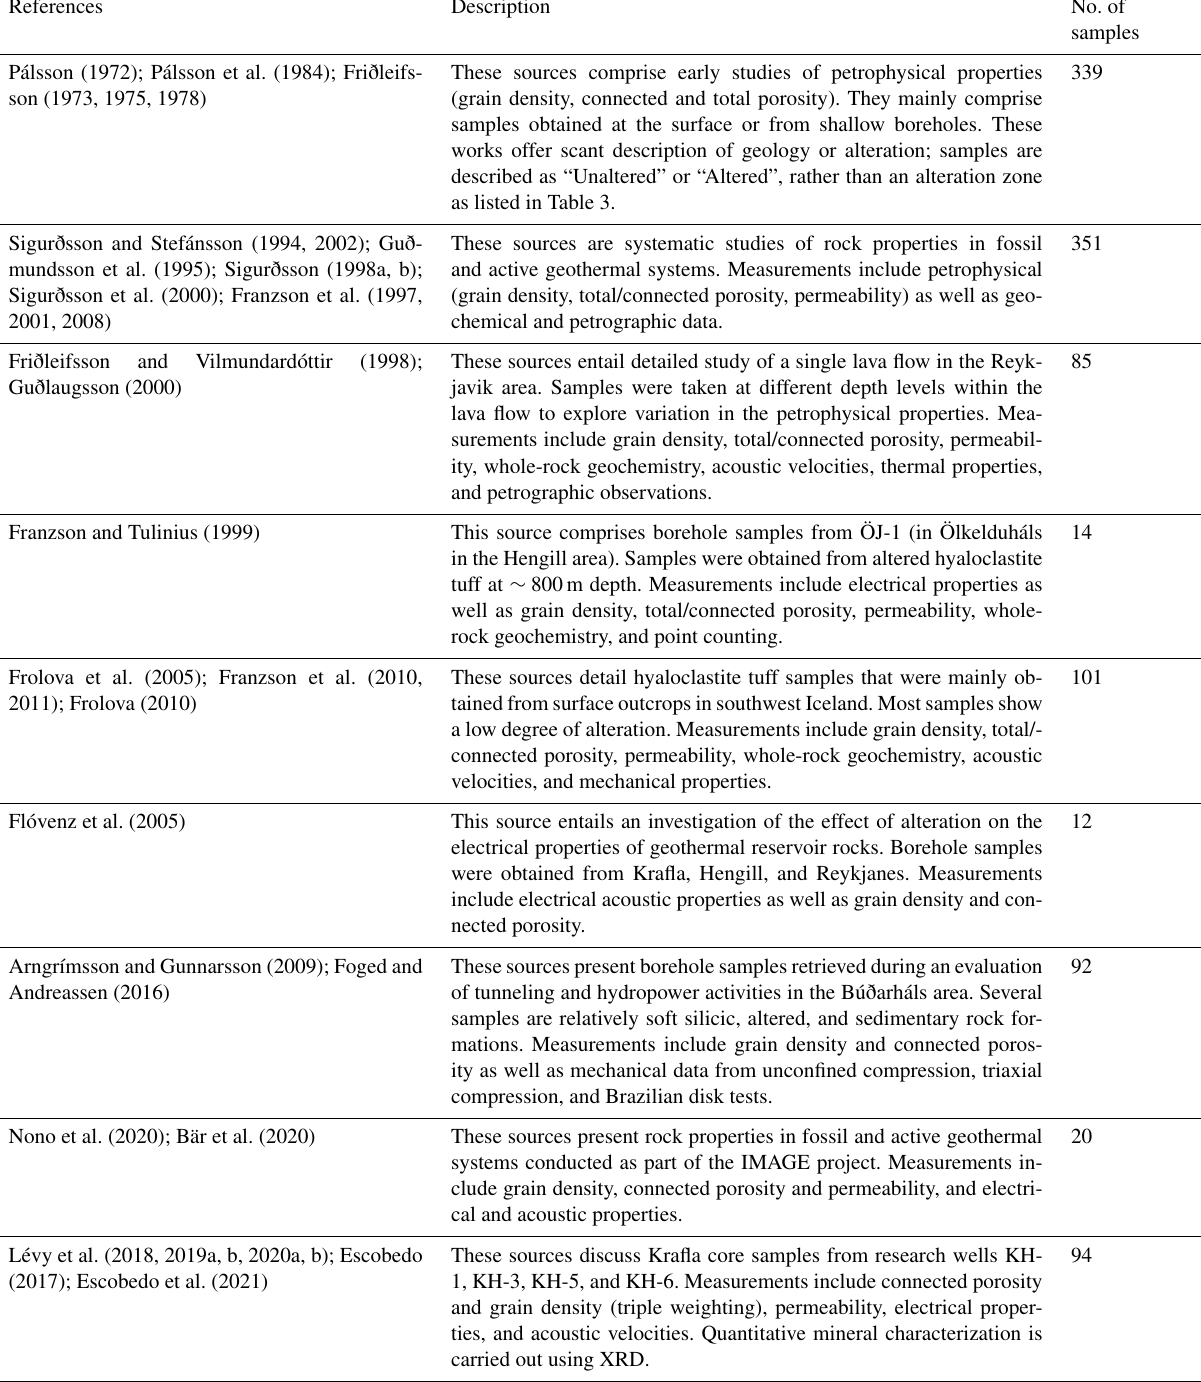
Table 1. Description of sources of data comprising the Valgarður